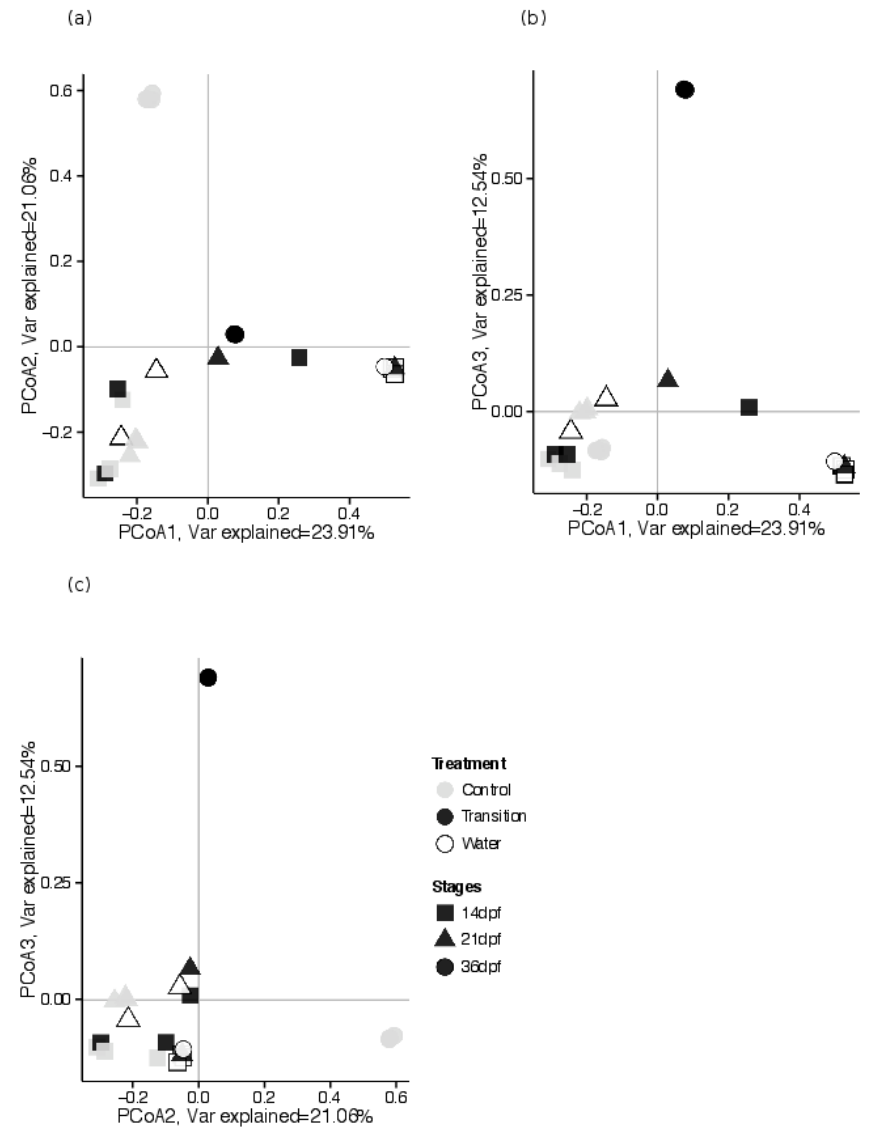
Figure 5. Visualization of measures of microbial community beta diversity (Bray–Curtis distance) based on multivariate principal coordinates analyses (PCoA) plots showing variation in larval lake sturgeon GI tracts and water microbial community compositional differences among collections made at different times and between control (CR) and transition (TR) food treatments. Samples were taken from replicates of different treatments at three developmental stages (before transition at 14d pf, during transition week at 21 dpf, after transition at 36 dpf). ( a ) Plot based on Bray–Curtis distance axis 1 and 2, ( b ) plot based on Bray–Curtis distance axis 1 and 3, ( c ) plot based on Bray–Curtis distance axis 2 and 3.